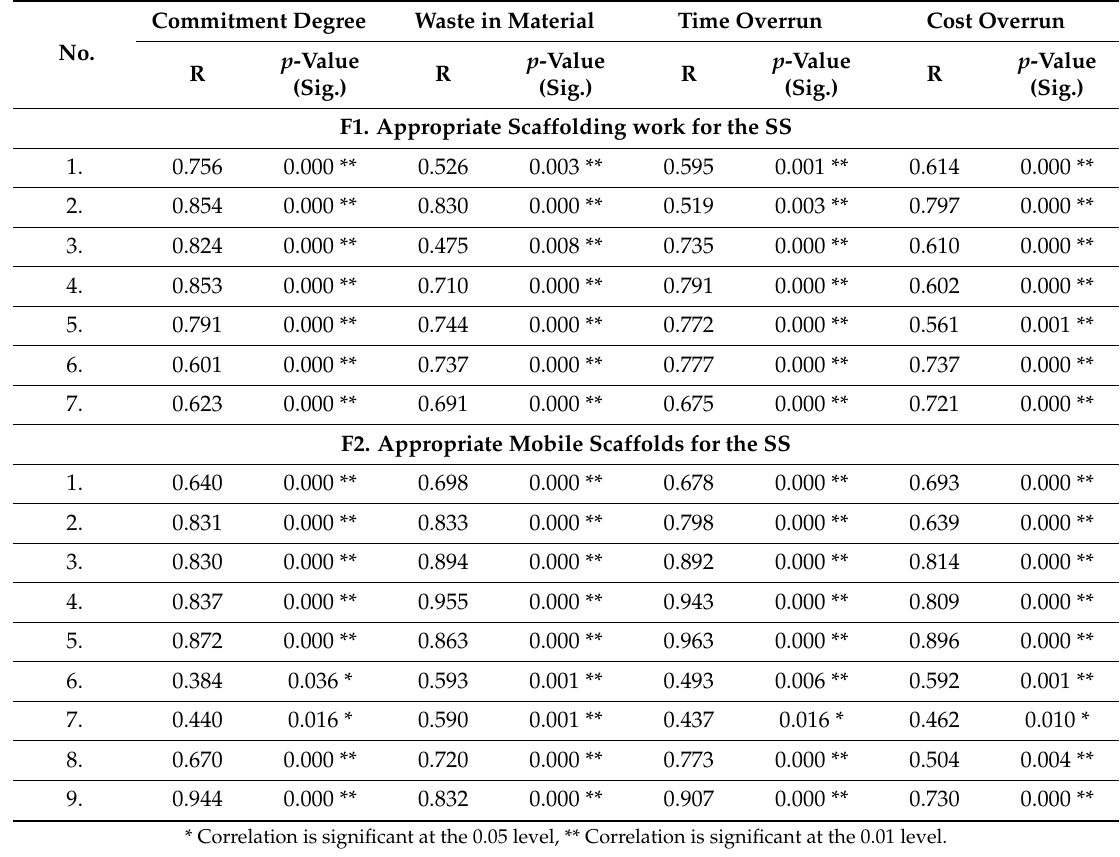
Table 5. R of each paragraph of IPh and the total of this